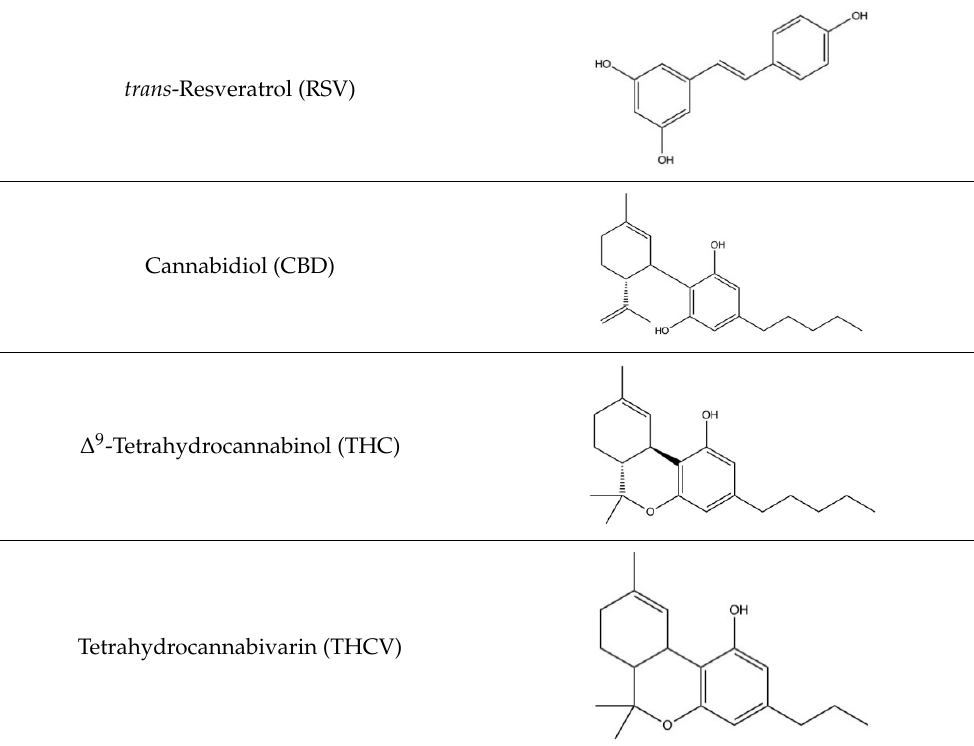
Table 1. Skeletal structures of the neuroprotective agents assessed in this review.